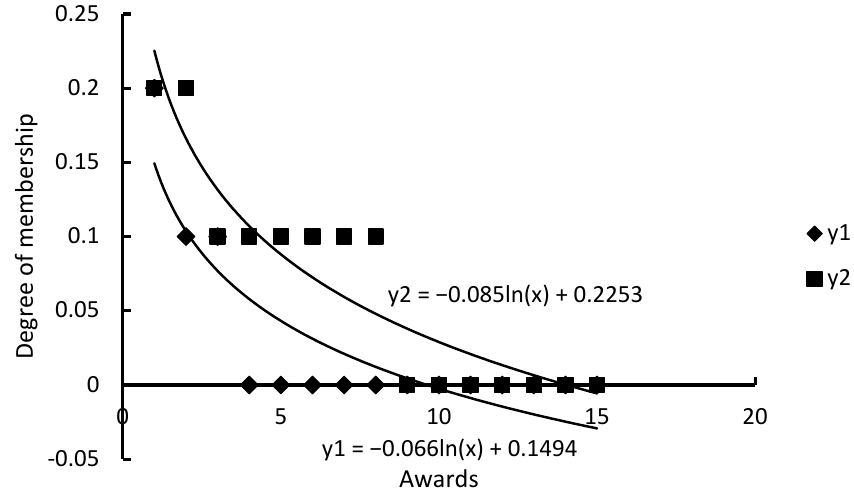
Figure A25. Single factor evaluation for the index of awards (one and more times).